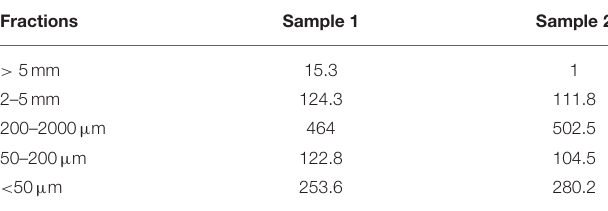
TABLE 3 | Weight distribution in g kg − 1 of the compost fractions (2 replicates).